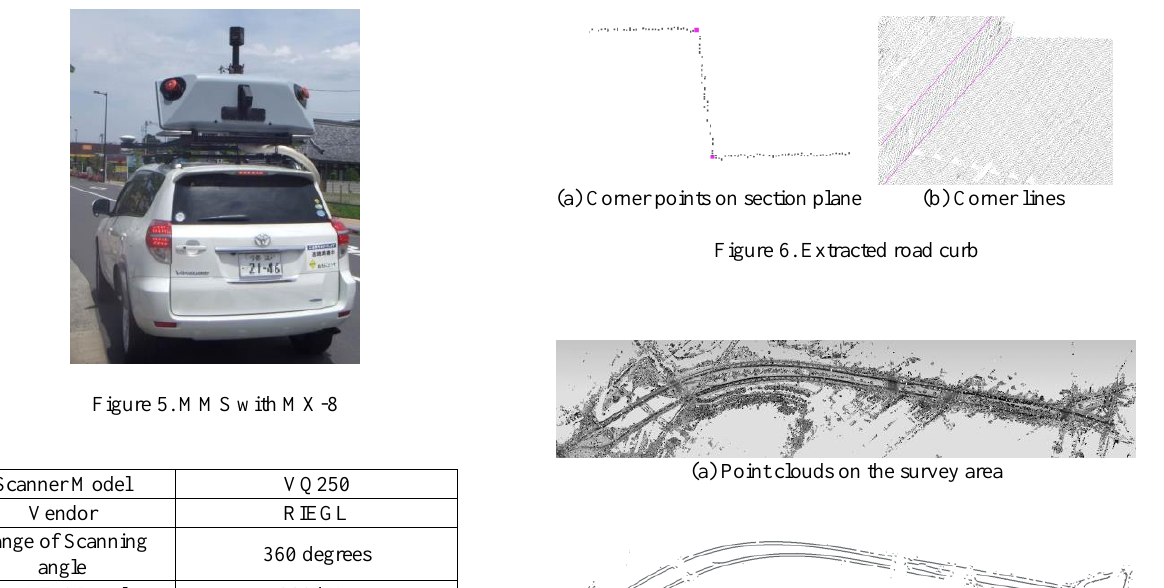
(b) Road boundary extracted from point cloud A